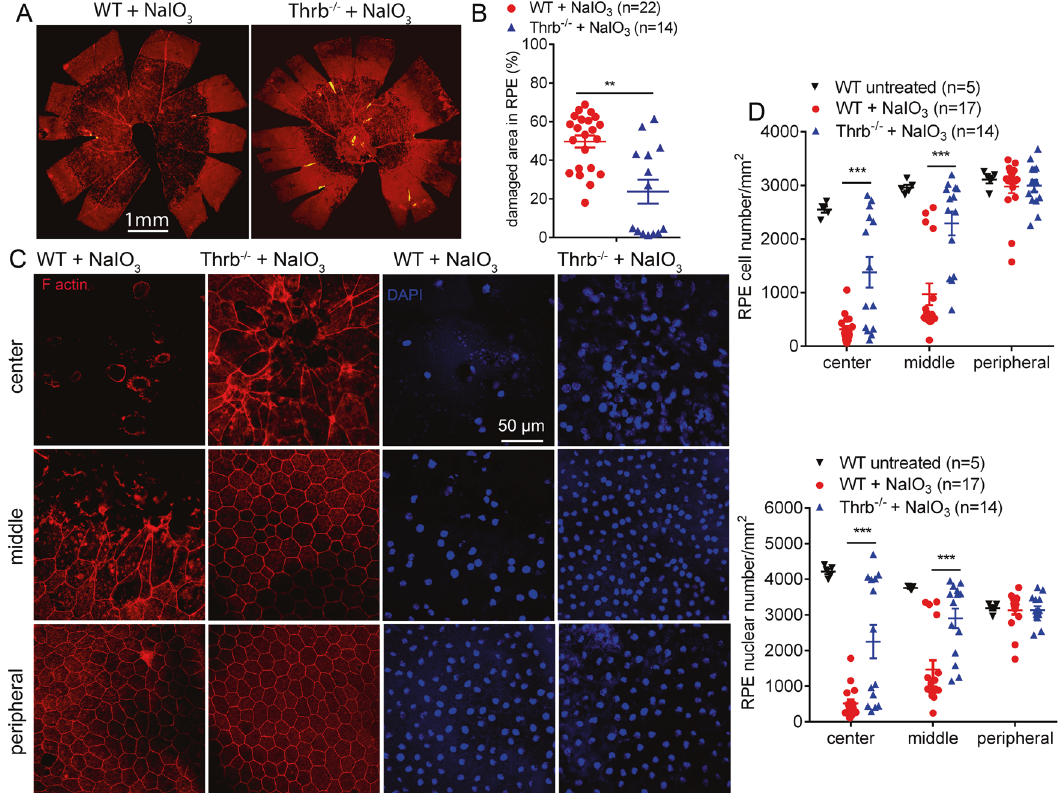
Fig. 3 Deletion of Thrb protected RPE from cell damage/loss induced by NaIO 3 . RPE morphology and cell loss were evaluated by phalloidin staining for F-actin and DAPI staining for nucleus on RPE whole mounts prepared from Thrb − / − and wild-type mice at 3 days post NaIO 3 injection. A , B Shown are representative low-magni fi cation images of phalloidin staining of the damaged area in the RPE ( A ) and corresponding quantitative analysis of the damaged area ( B ). C , D . Shown are representative high-magni fi cation images of phalloidin staining and DAPI labeling taken at different regions of the RPE ( C ) and corresponding quantitative analysis of RPE cell numbers and RPE nuclear numbers ( D ). Data are represented as means ± SEM for 5 – 22 mice per group (** p < 0.01, *** p < 0.001, compared with wild-type mice treated with NaIO 3